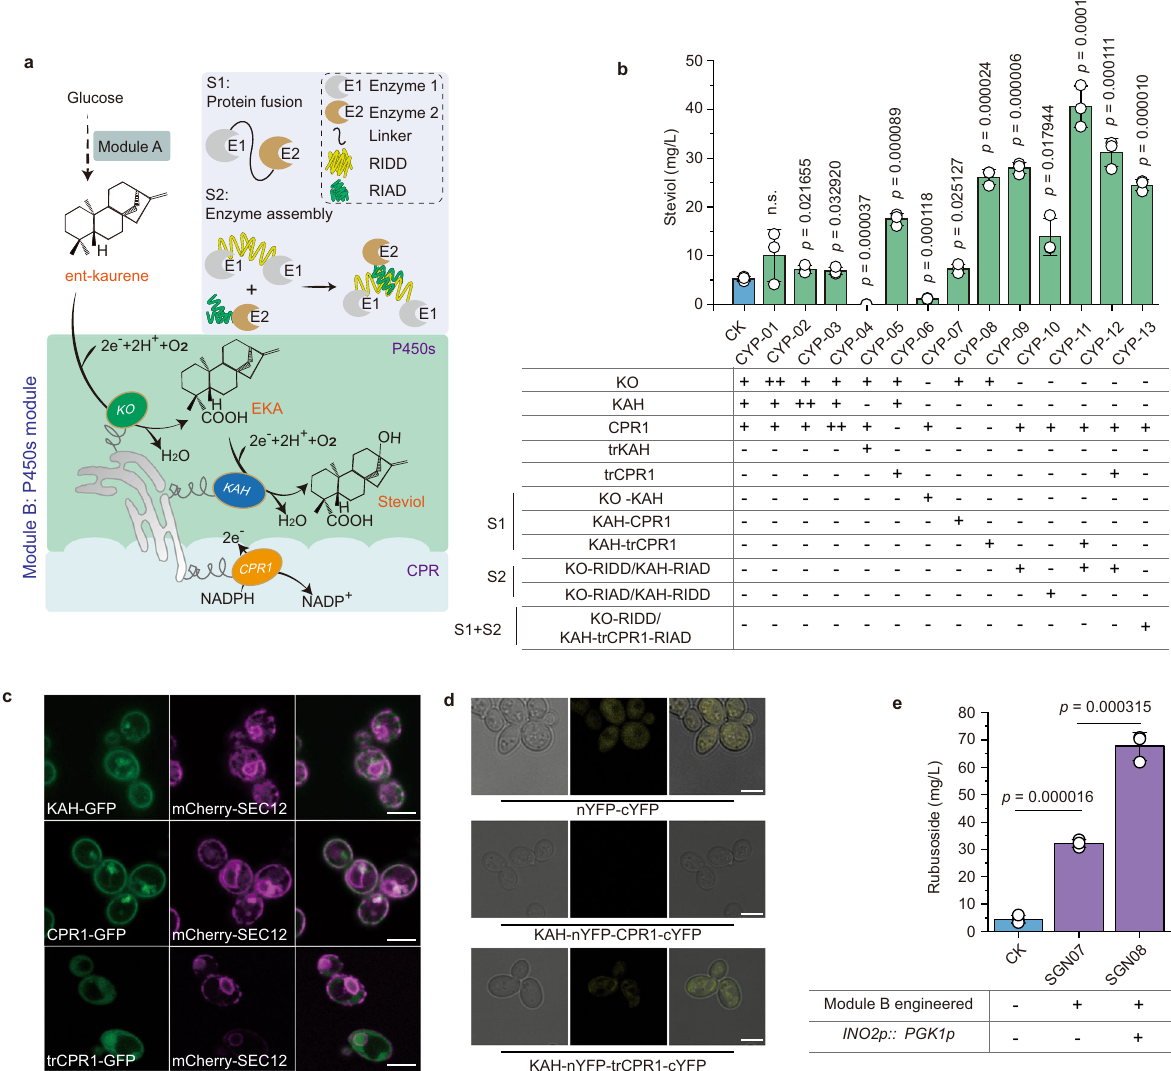
Fig. 2 Eliminating the rate-limiting steps in the P450s module. a Illustration of different strategies for relieving the rate-limiting steps. S1 (Strategy1), proteins fused by a short protein linker (GGGGS 3 ), S2 (Strategy2), enzymes fused with a pair of short peptide tags (RIAD and RIDD). NADPH nicotinamide adenine dinucleotide phosphate, NADP + nicotinamide adenine dinucleotide phosphate. b Changes of steviol titer by modifying the P450s. S1, proteins fused by a linker (GGGGS 3 ), S2, enzymes fused with a pair of short peptide tags (RIAD and RIDD). CK presents the SGN05 strain. c Visualized analysis of the subcellular localization of the P450s KAH and reductase CPR1. The fl uorescence images in the fi rst row are KAH-GFP (left, green) and mCherry-SEC12 (middle, magenta) and merge images (right). The fl uorescence images in the second row are CPR1-GFP (left, green), mCherry-SEC12 (middle, magenta), and merge images (right). The fl uorescence images in second row are trCPR1-GFP (left, green), mCherry-SEC12 (middle, magenta), and merge images (right). Bar = 5 μ m. d BiFC of KAH fused with nYFP, and CPR1/trCPR1 fused with cYFP. Confocal images of the cells expressing nYFP-cYFP (top), KAH- nYFP-CPR1-cYFP (middle), and KAH-nYFP-trCPR1-cYFP (bottom). cYFP C-terminal 186 – 250 amino acid residues, nYFP N ‐ terminal 1 ‐ 185 amino acid residues. Bar = 5 μ m. e Increased rubusoside biosynthesis by eliminating the rate-limiting steps in P450s module (Module B), and overexpressing the ER regulator INO2 by replacing it promoter ( INO2p ) with a stronger one PGK1p . CK (the SGN06 strain). b , e Data are presented as mean values± SD from three independent biological replicates ( n = 3), the circles represent individual data points. Signi fi cance ( p -value) was evaluated by two-sided t -test, no signi fi cance (n.s.) presents p > 0.05. b , c Image analysis was carried out on the Leica LAS X software package and the ImageJ 1.53k software.